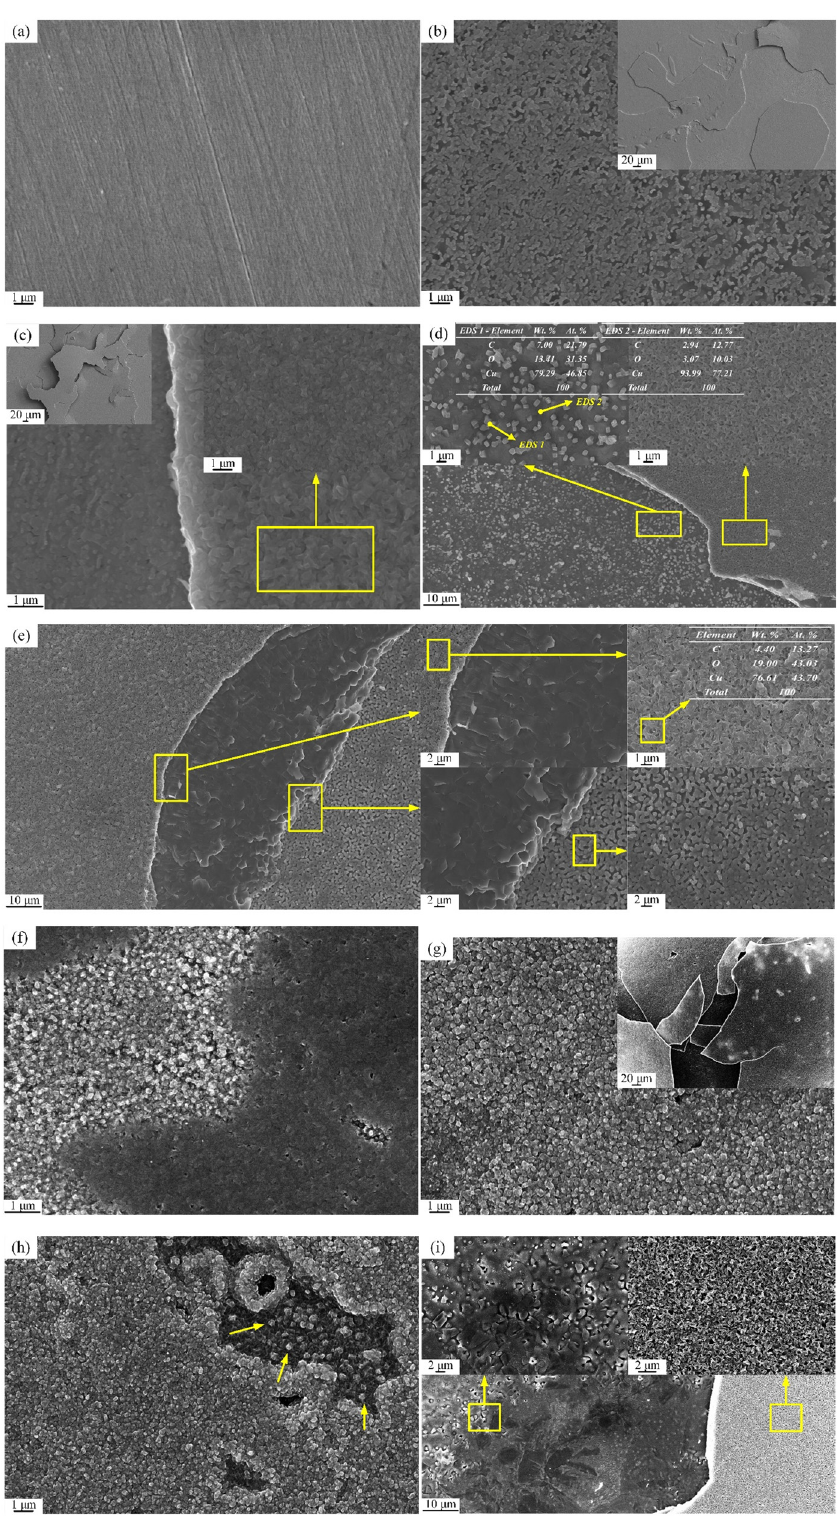
Figure 5: SEM surface morphology of the copper samples after oxidation at ( a ) 0.5 min, ( b ) 1 min, ( c ) 2 min, ( d ) 3 min, ( e ) 4 min, ( f ) 5 min, ( g ) 10 min, ( h ) 20 min, and ( i ) 30